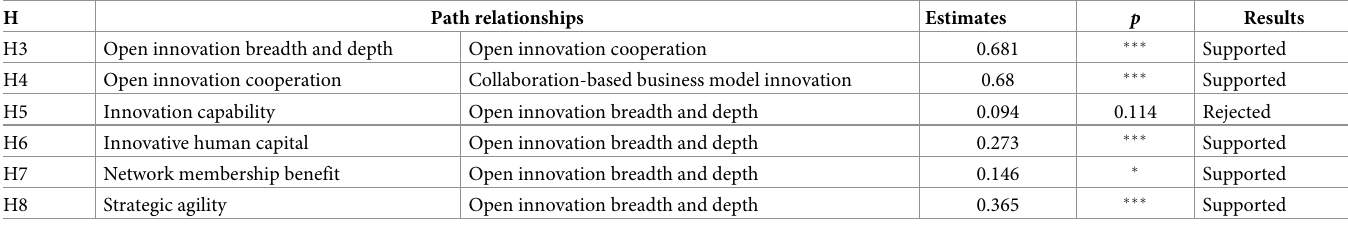
Table 6. Structural model.